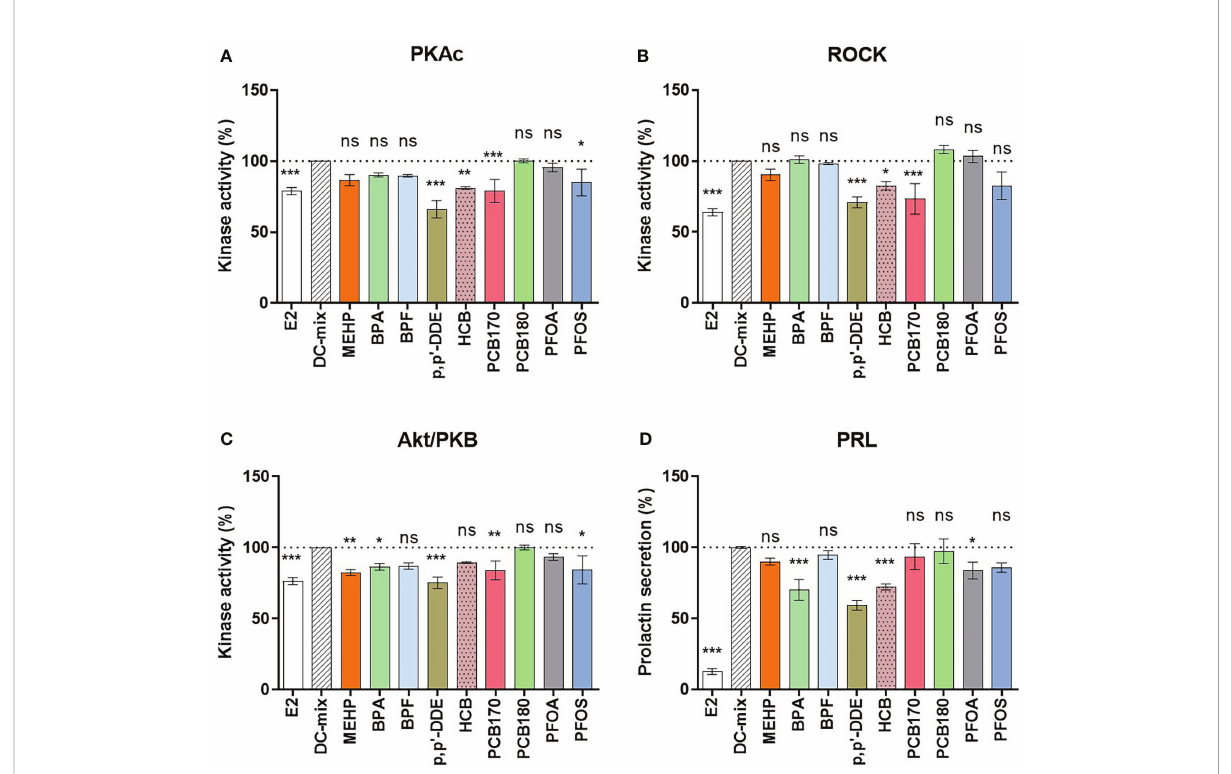
FIGURE 2 Screening of nine EDCs for effects on decidualization. The eSCs of two women (N=2) were exposed to the decidualization-inducing mixture (DC-mix) in the absence or presence of 9 different EDCs (1 µM) for 9 days, and 10 nM E2 was used as a negative control. Altogether 10 independent assays were carried out (n=10). Protein kinase activity was assessed in lysates (normalized to protein content) using a competitive photoluminescent probe displacement assay, and calculated as percentage of DC-mix (100%) for (A) PKAc, (B) ROCK and (C) Akt/PKB. (D) Secreted PRL was measured in spent media representing the last 72 h of the in vitro treatment using a human PRL ELISA kit. Values are expressed as mean percentage of DC-mix alone ± SEM (N = 2, n = 10). Signi fi cance is calculated by one-way ANOVA with Dunnett test for multiple comparisons (95% CI) relative to DC-mix and indicated as *P<0.05, **P<0.01 and ***P<0.001 and ns, not signi fi cant. The dotted line corresponds to